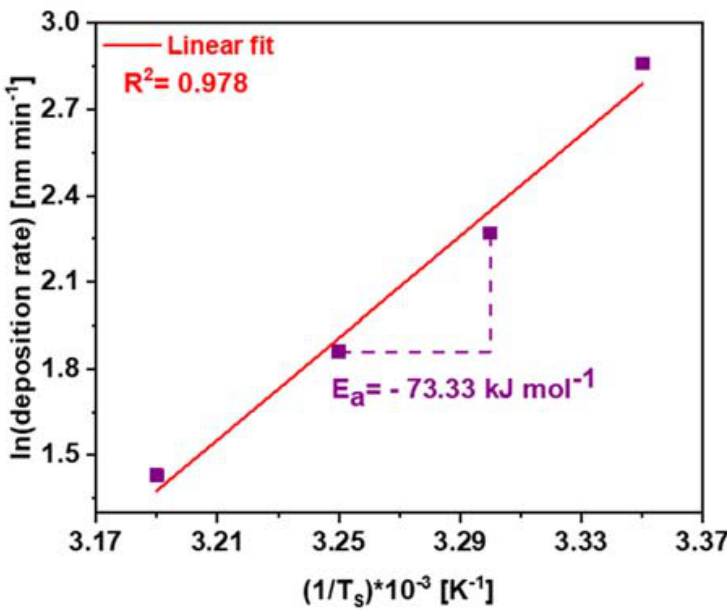
Figure 3. Arrhenius plot of deposition rate as a function of varying substrate temperature ( T s ) to derive the activation energy ( E a ) for iCVD of PMBL.